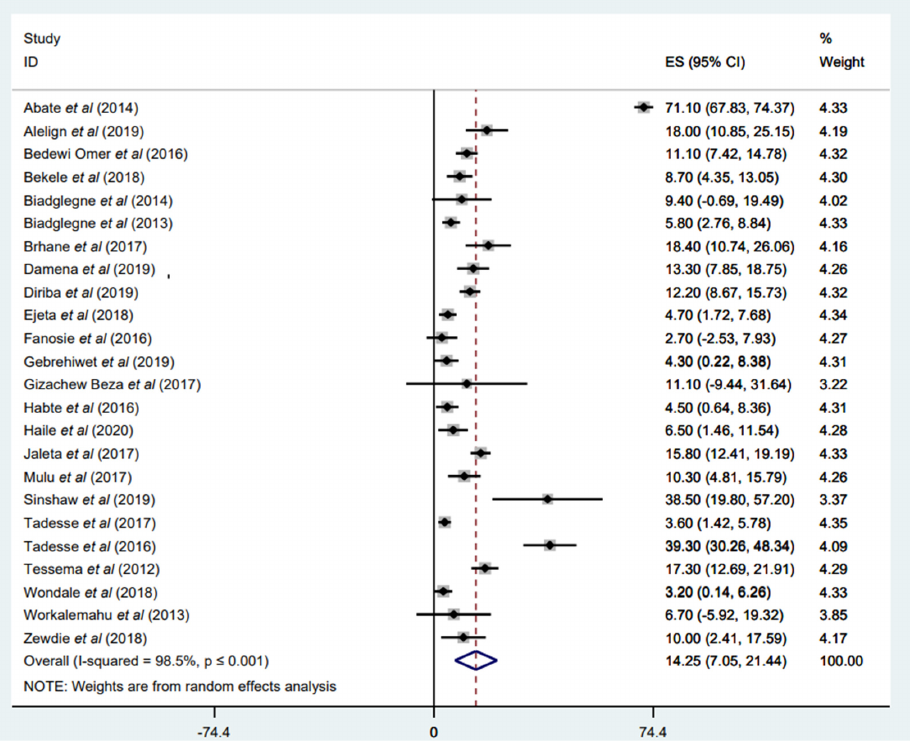
Figure 2. Forest plot showing the weighted pooled prevalence of any anti-TB drug resistance in patients with TB.